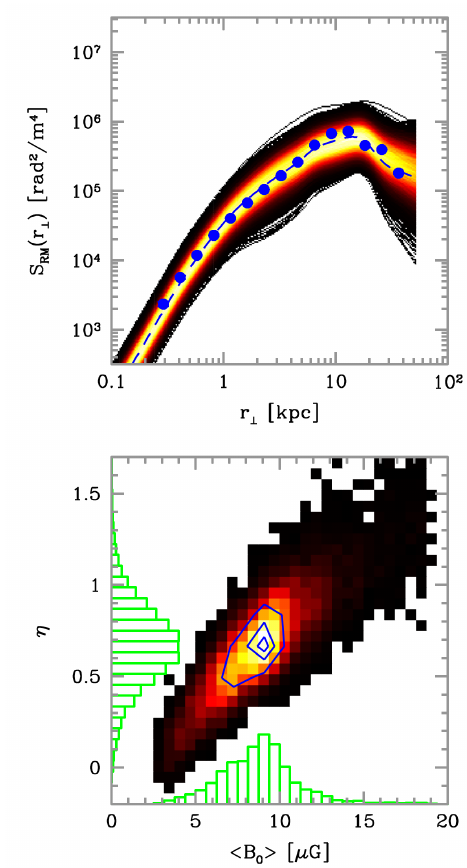
Figure 3. Results from the Bayesian 3-dimensional analysis of the rotation measure structure function in the galaxy cluster A2199 [27]. Top : dots represent the data, the shaded area represents the population of synthetic RM structure functions from the posterior distribution, and the dashed line corresponds to the most probable value for the model parameters. Bottom : one-dimensional (histograms) and two-dimensional (colors and contours) marginalizations of the posterior for the model parameters (cid:104) B (cid:105) and η 0